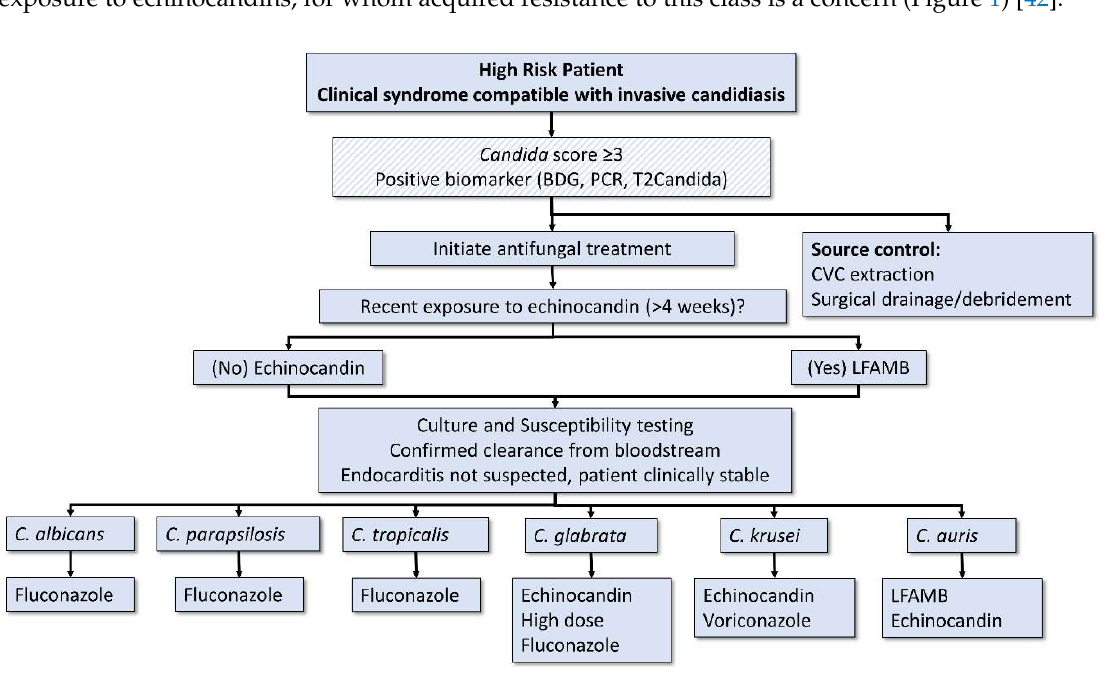
Figure 1. Treatment algorithm for patients with suspected or confirmed invasive candidiasis. Scored fill pattern indicates an optional step. For considerations regarding timing of CVC removal, see text. Echinocandin indicates caspofungin, micafungin or anidulafungin. BDG: (1,3)-β- D -glucan; LFAMB: lipid formulation of amphotericin B; CVC: central venous catheter.